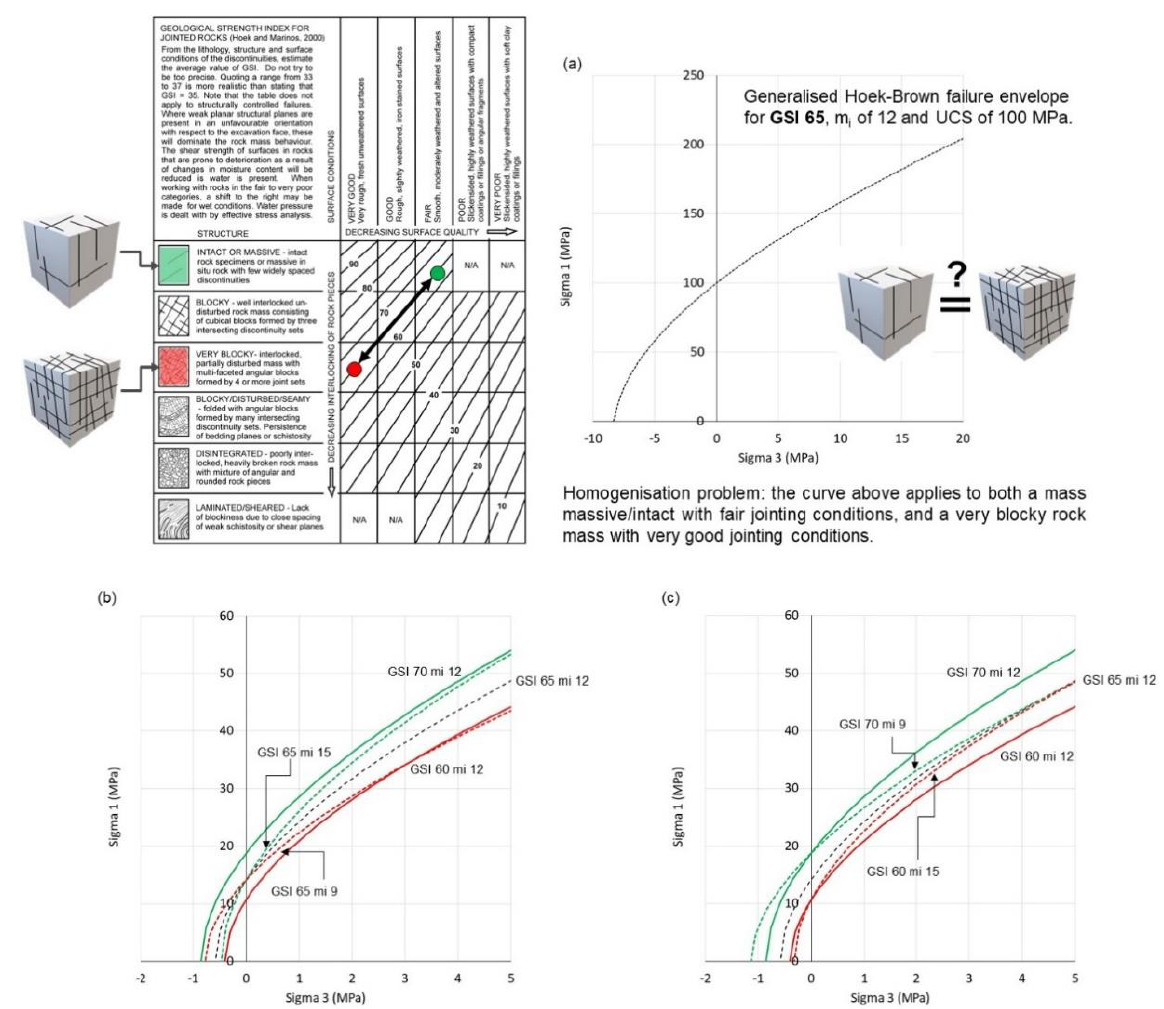
Figure 7. Irreversibility bias associated with a lack of detailed geological description. ( a ) The same rock mass behavior could be linked to both a massive/intact with fair jointing conditions and very blocky with very good jointing conditions. ( b , c ) show the combined impact of GSI and mi on the modelled rock mass response, highlining the impossible task to define a unique failure envelope for naturally variable rock masses.